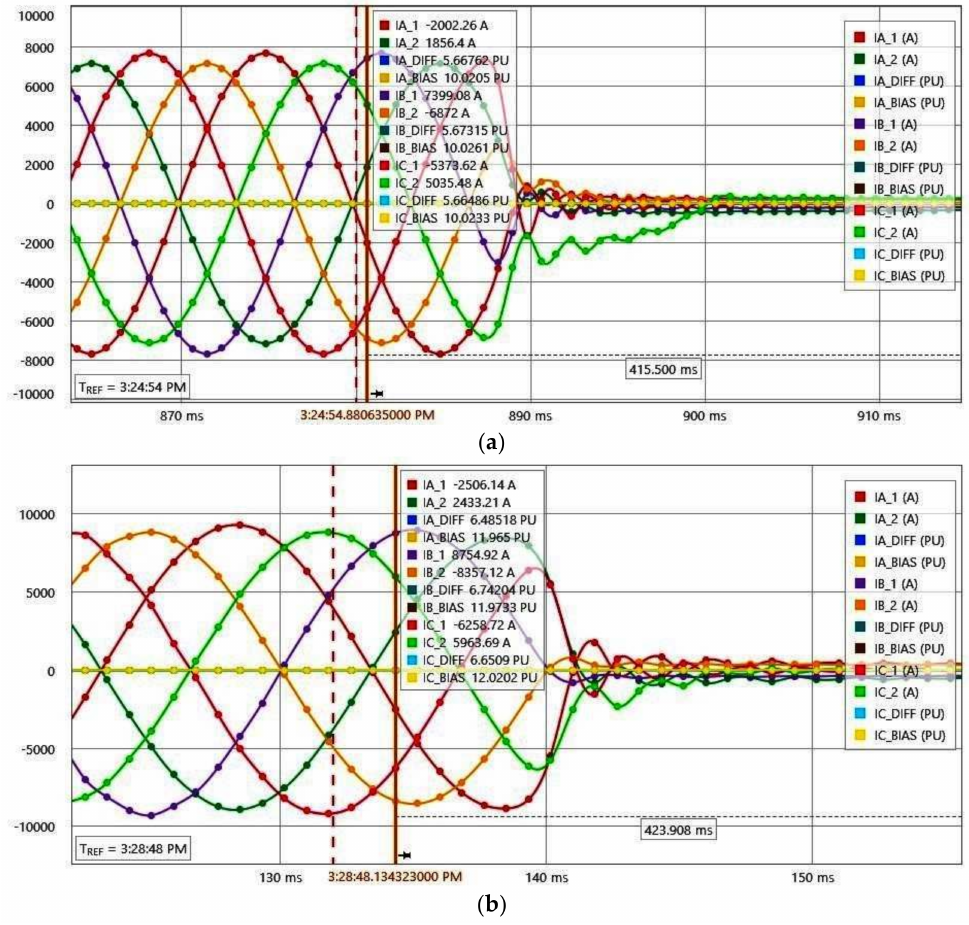
Figure 10. Waveforms of bias characteristics for points selected in accordance with setting ‘ I S − H S 1 ’ and ‘ I S − H S 2 ’ in Figure 11a: ( a ) point H, ( b ) point